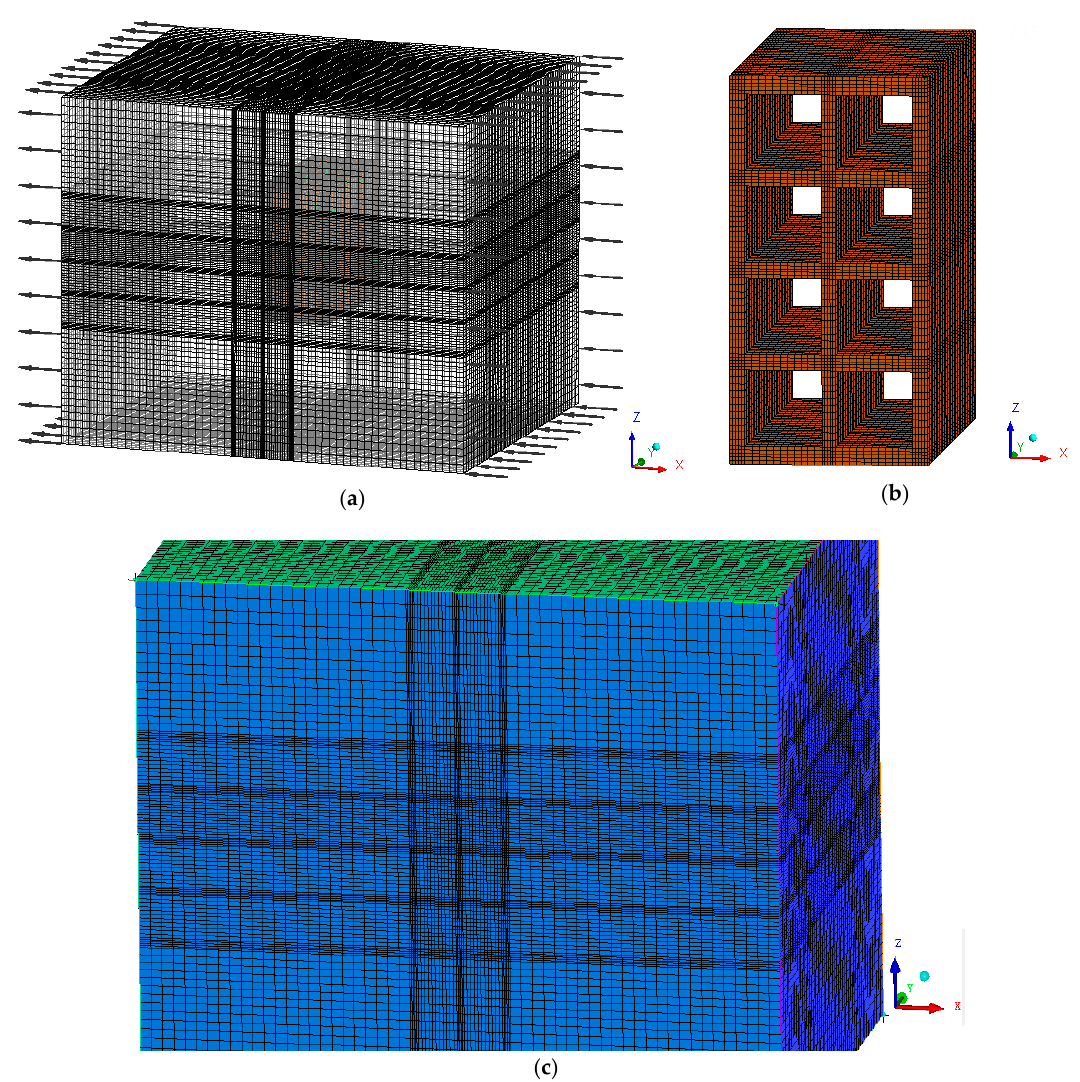
Figure 3. Mesh of ( a ) the full domain, ( b ) the brick, and ( c ) details of oven surface.